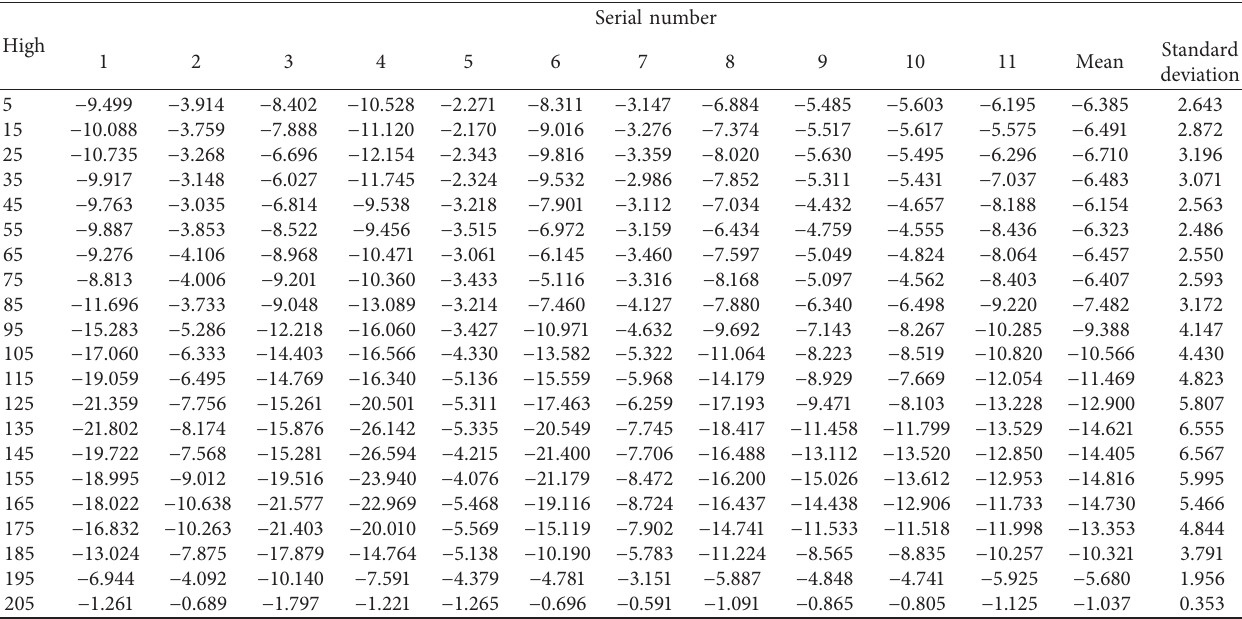
Table 16: Maximum earthquake tensile stresses of the 210 m high chimney when only horizontal seismic acceleration is inputted.